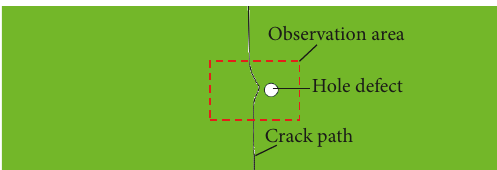
Figure8:Crackpathbasedonthenumericalsimulationofextended finite element